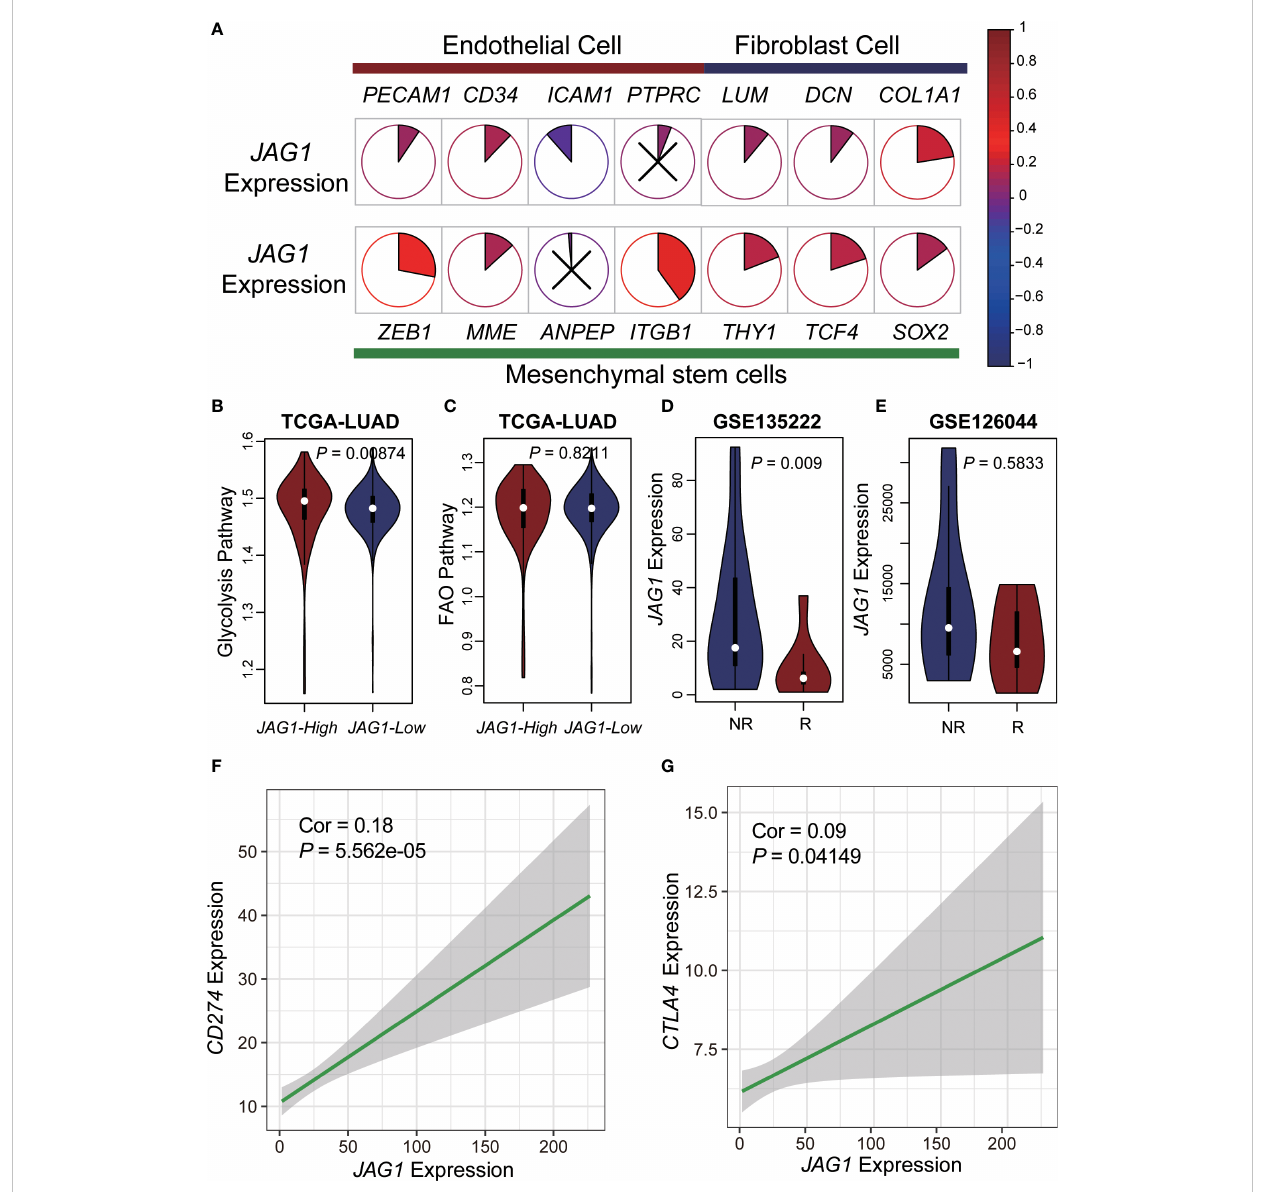
FIGURE 5 Metabolic characteristics and immunotherapy resistance of JAG1 -high patients. (A) The pie plot showed the correlation of JAG1 expression and basal cells markers. Colors represented correlation coef fi cients, blue for negative and red for positive correlations. And, the sector area also represented the correlation. P < 0.05 was considered signi fi cant, and those that were not signi fi cant were marked with X. (B, C) The violin plot of glycolysis and FAO pathway activation. (D, E) The expression of JAG1 between respond and non-respond group in two anti-PD1/PD-L1 immunotherapy cohorts. (F, G) The scatter plot of JAG1 expression and CD274, CTLA4